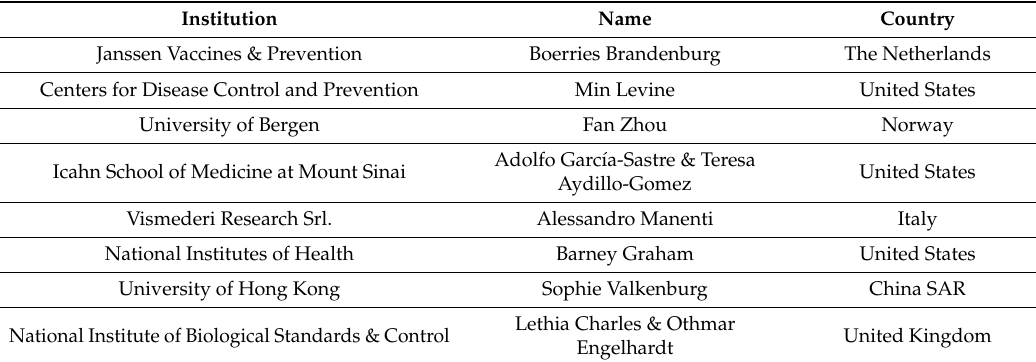
Table 1. Laboratories participating in pilot collaborative